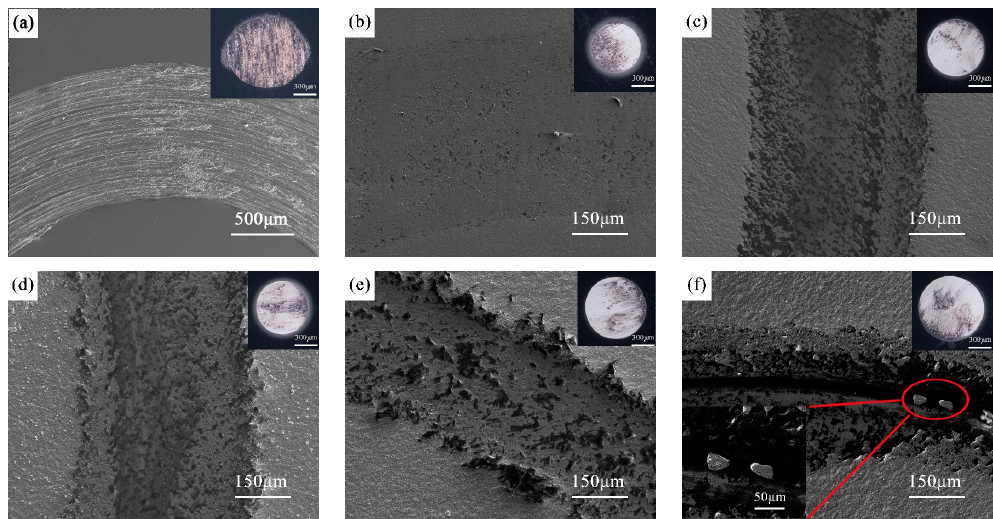
Figure 8. Wear scar morphologies of grinding ball and titanium alloy after ( a ) polishing and nitriding at ( b ) 750 °C, ( c ) 800 °C, ( d ) 850 °C, ( e ) 900 °C, and ( f ) 950 °C.